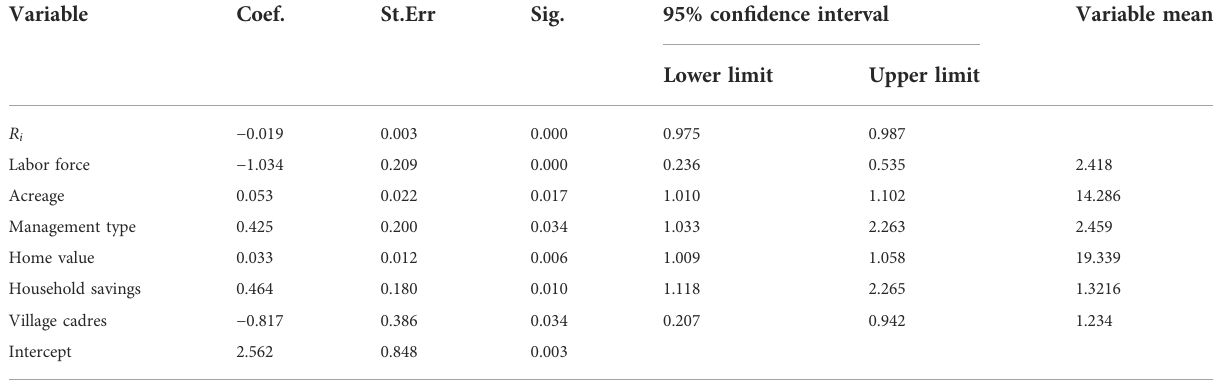
TABLE 6 Estimated results of WTP for respondents of the double-bound dichotomous CVM. Variable